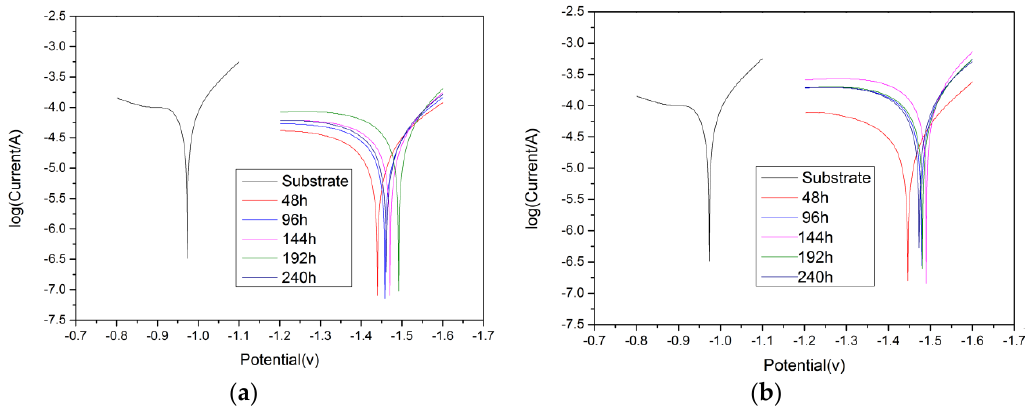
Figure 7. Potentiodynamic polarization curves of Zn-Al-Mg-TiO 2 coating in 3.5% NaCl solution for different time periods (reference electrode: calomel): ( a ) potentiodynamic polarization curves of the coating under ultraviolet conditions; ( b ) potentiodynamic polarization curves plot of the coating under no ultraviolet conditions.